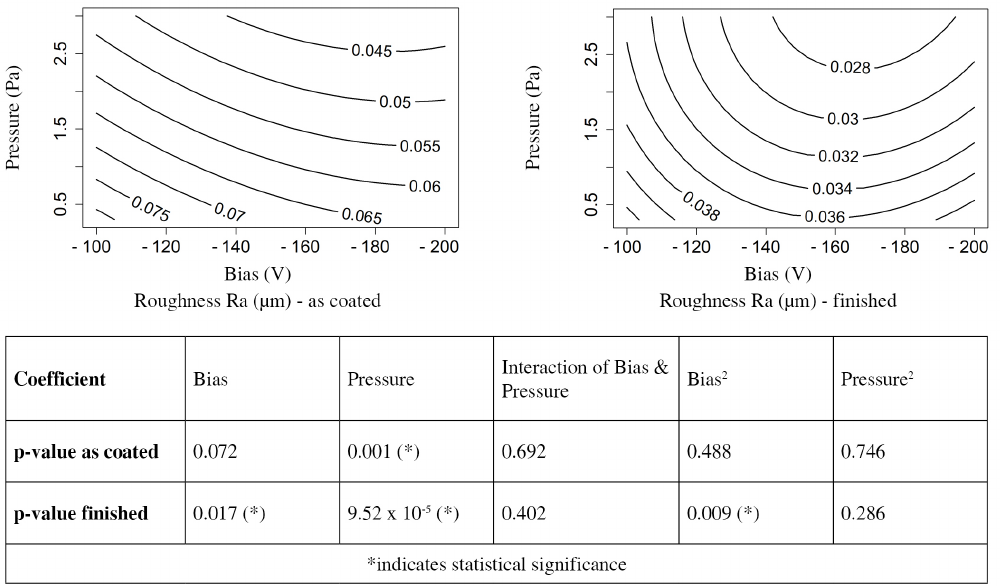
Figure 2. Scatter plots and response surface of the line roughness Ra as coated and finished.